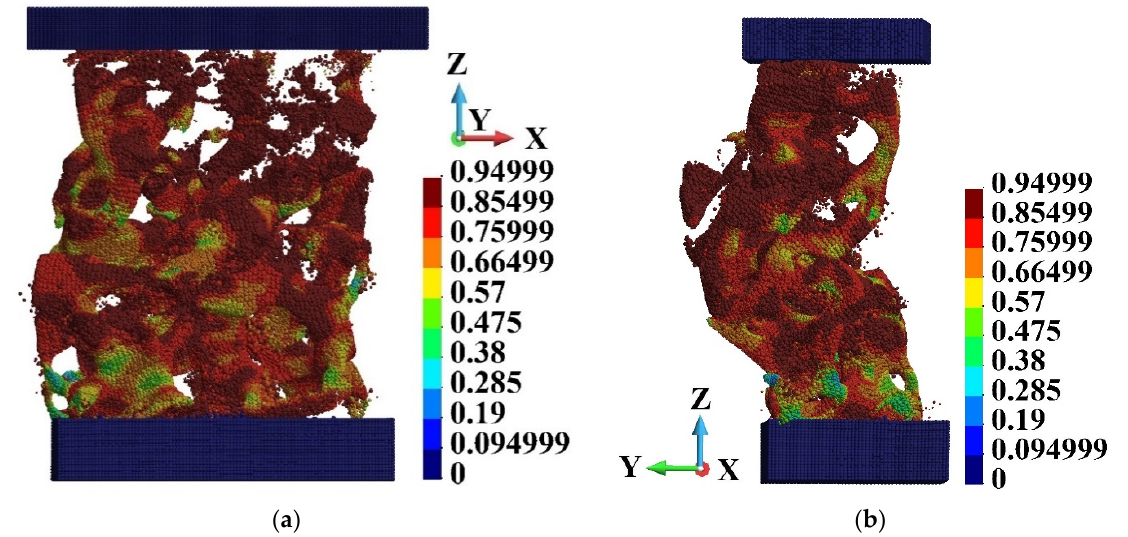
Figure 16. Damage distribution and shape of the foam under piston velocity 440 m/s at the end of the process: ( a ) X-Z plane view; ( b ) Y-Z view.